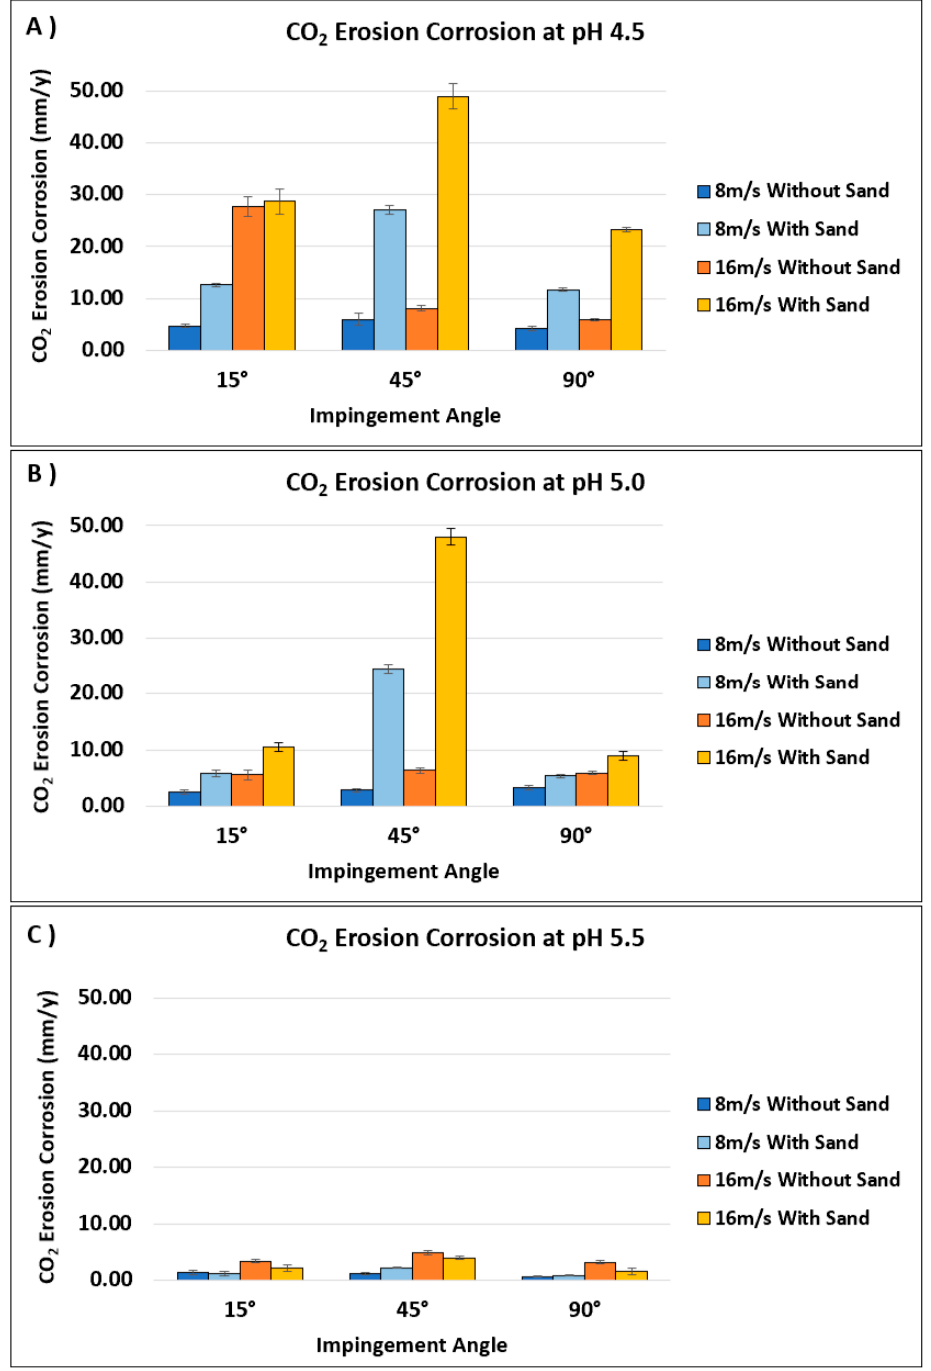
Figure 11. Performance of CO 2 erosion–corrosion rates with varying impingement angles (15 ◦ , 45 ◦ , and 90 ◦ ), impingement velocities (8 and 16 m / s), availability of sand particles (2000 ppm), and pH values: ( A ) pH 4.5, ( B ) pH 5.0, ( C ) pH